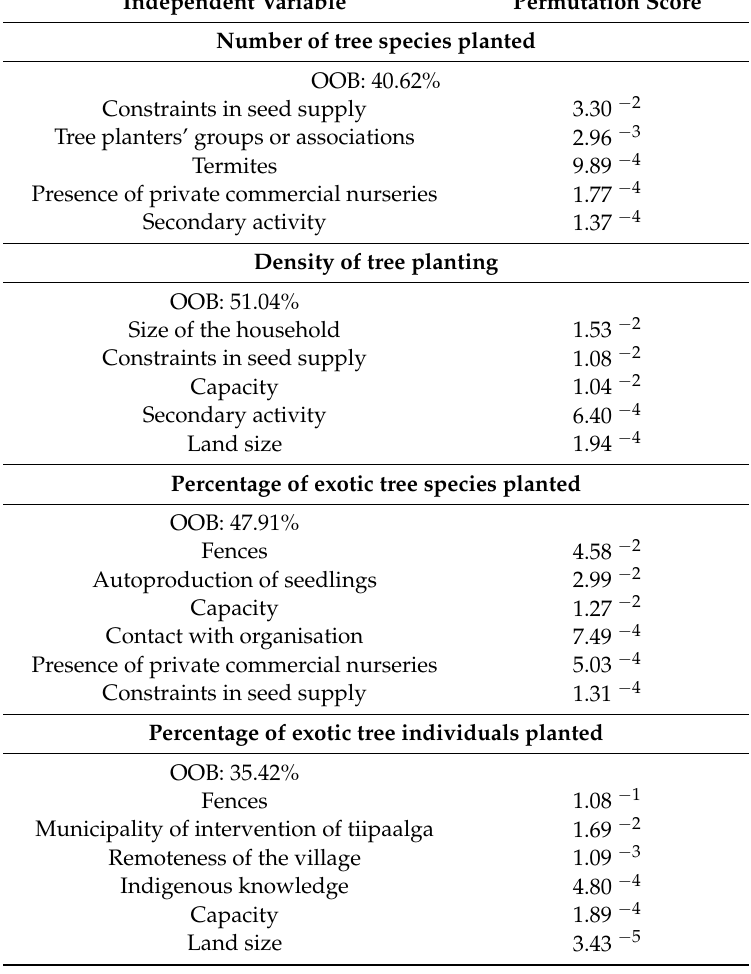
Table 4. Permutation score of all the most relevant independent variables in the four random forest models developed, one for each of the four dependent variables. The out of bag score (OBB) indicates the proportion of wrong predictions obtained using each model from 5000 runs of the